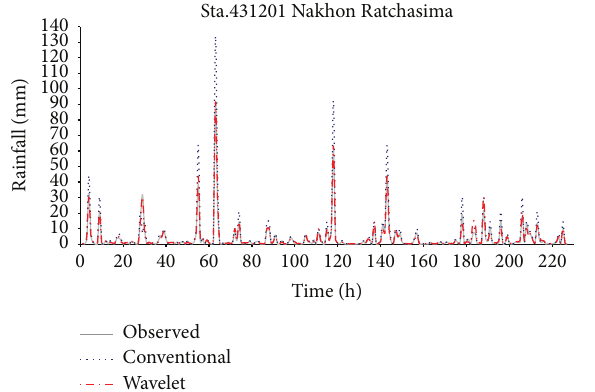
Figure 17: Cumulative observed rainfall data at sta.436201 Buriram during 1 June–31 October 2011 for verification compared with conventional and wavelet filters